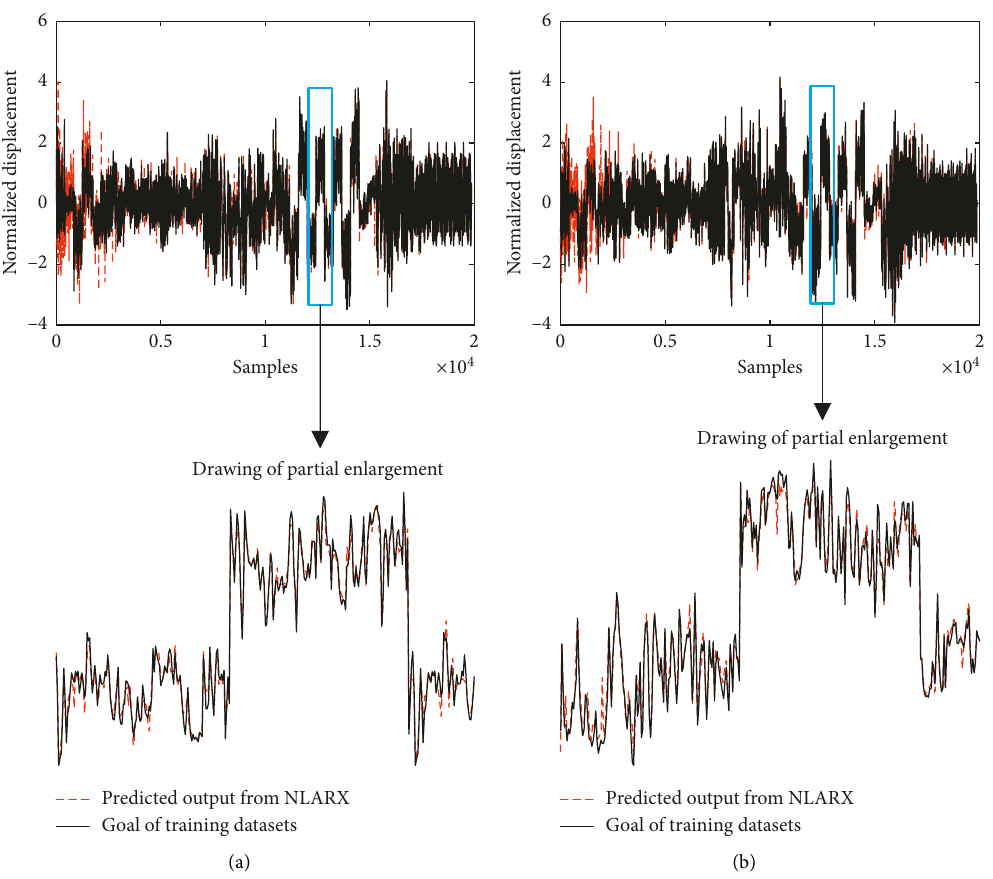
Figure 9: NLARX results for training datasets: (a) left external loads; (b) right external